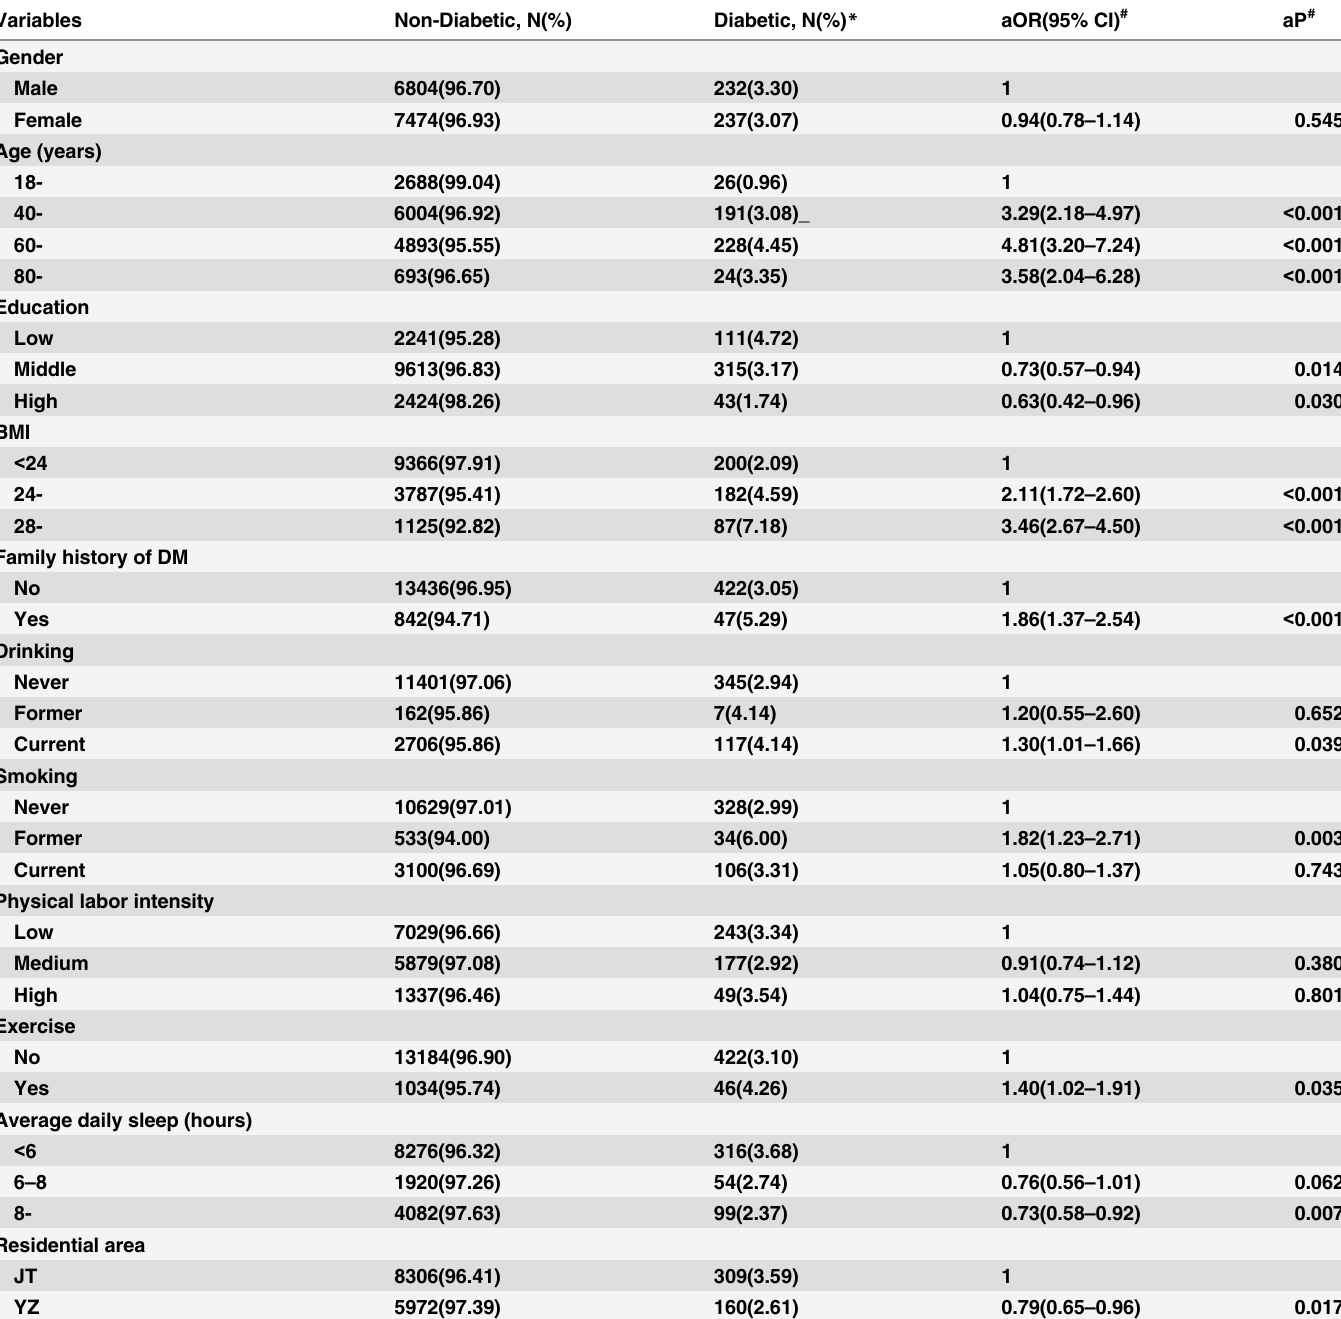
Table 3. Factors associated with the possible risk of